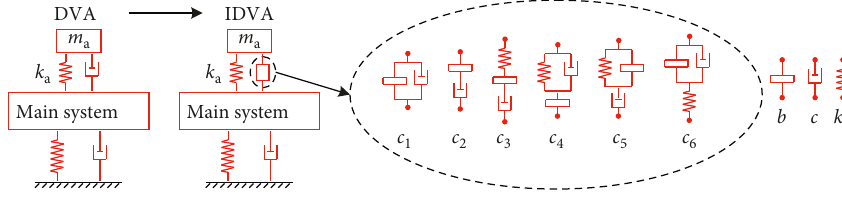
Figure 2: The model of the DVA and